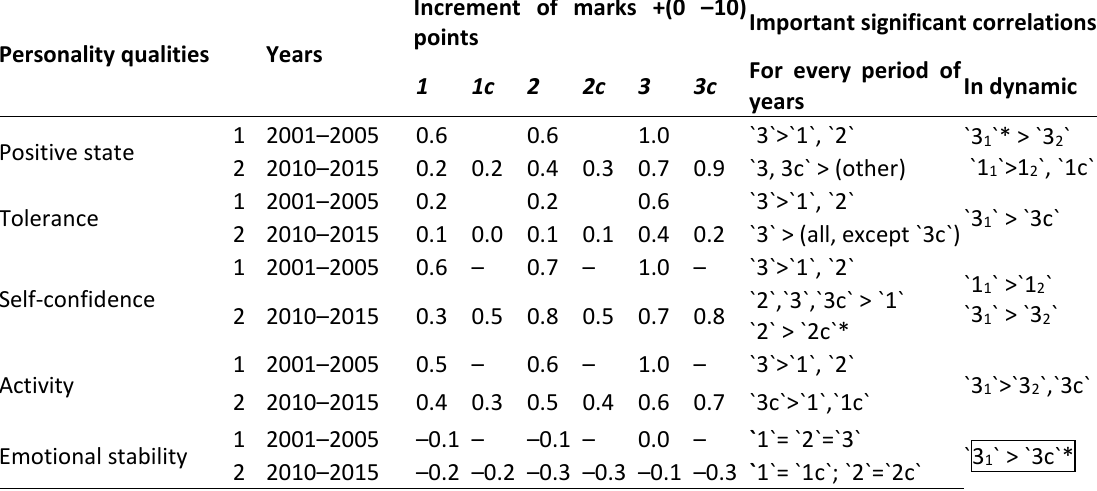
Table. Average increment of students’ HLS personality componentsТ for study